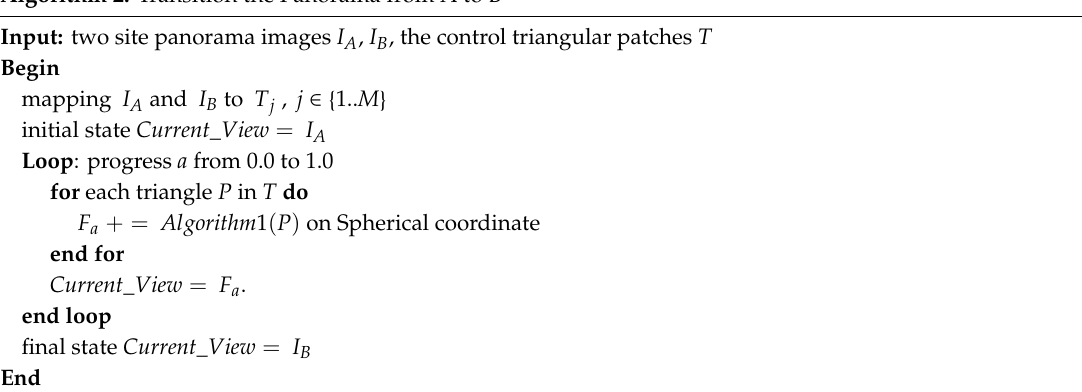
Algorithm 2: Transition the Panorama from A to